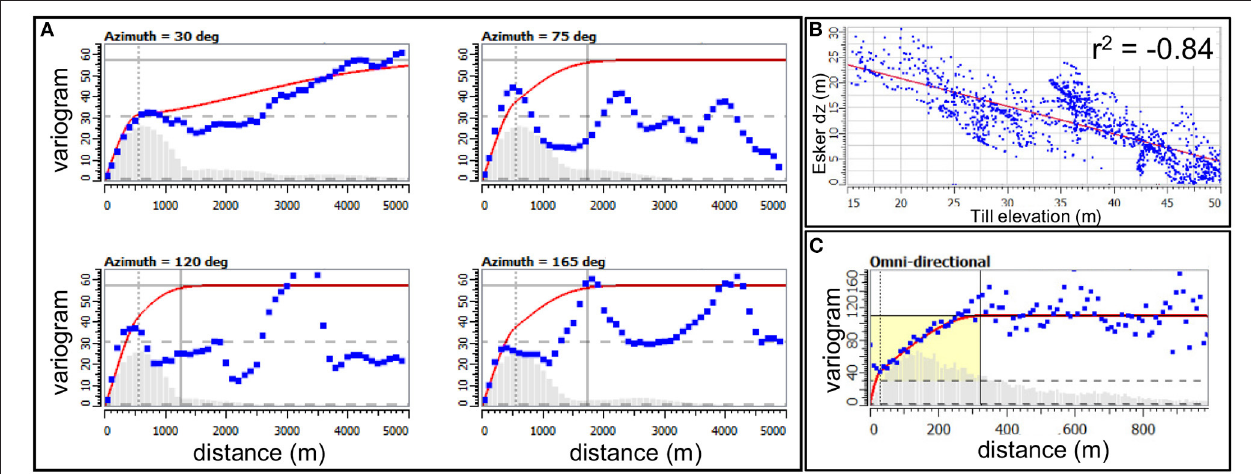
FIGURE 4 | (A) Experimental and modeled variograms for Esker Sand and Gravel unit thickness computed on medium and long range data with all data available. (B) Crossplot between Esker Sand and Gravel unit thickness (Esker dz) and Till unit elevation (Till elevation). (C) Experimental and modeled variograms for Esker Sand and Gravel unit thickness computed on short range with well markers only.